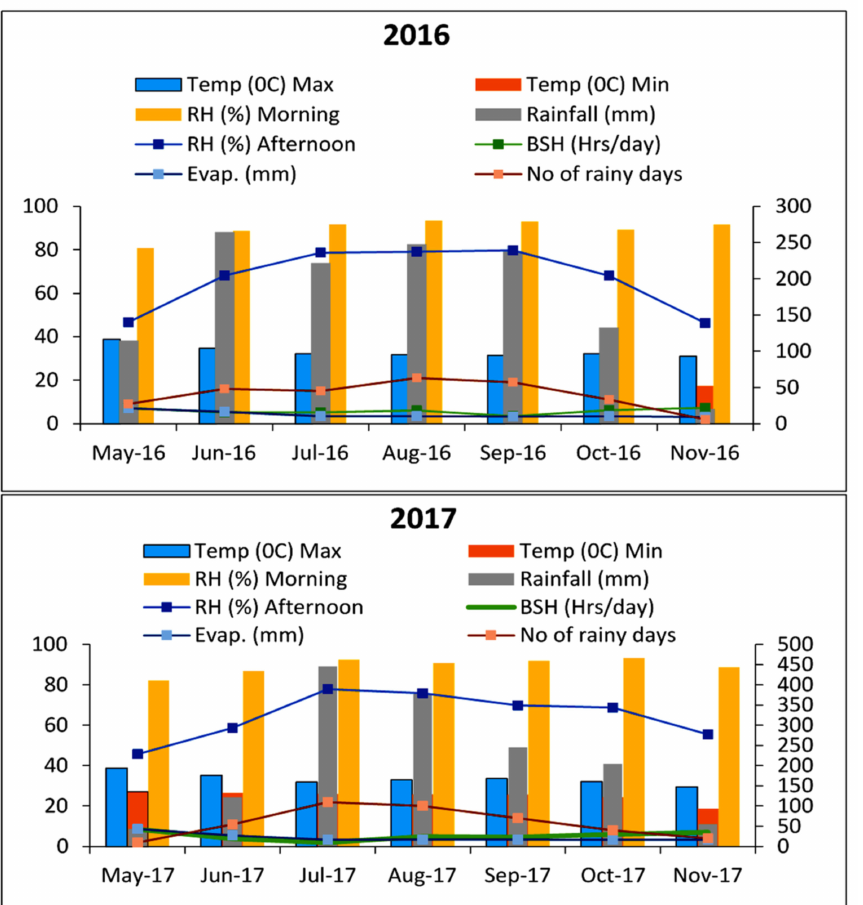
Figure 1. Monthly meteorological data during crop growing season ( kharif ) during 2016 and 2017